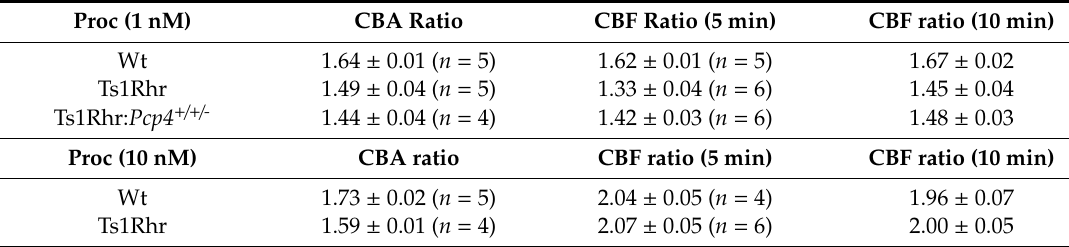
Figure 2. Increases in CBF and CBA ratios of airway cilia stimulated by 1 nM procaterol. Stimulation with procaterol (1 nM) increases CBF and CBA ratios of airway cilia in Wt, Ts1Rhr, and Ts1Rhr: Pcp4 +/+/ - . ( A ) Wt. The time course of the procaterol-stimulated CBF-increase is slower than that of the procaterol-stimulated CBA-increase. ( B ) Ts1Rhr. The time course of the procaterol-stimulated CBF increase is much slower in Ts1Rhr than in Wt. The plateau levels of the procaterol-stimulated CBF and CBA increases in Ts1Rhr are lower than those in Wt. ( C ) Ts1Rhr: Pcp4 +/+/ - . The time course of the procaterol stimulated CBF increase in Ts1Rhr: Pcp4 +/+/ - is similar to that in Wt, although the plateau levels of CBF and CBA during procaterol stimulation are lower in Ts1Rhr than in Wt. ( D ) The time courses of procaterol-stimulated CBF and CBA increases in Wt, Ts1Rhr, and Ts1Rhr: Pcp4 +/+/ - . The procaterol-stimulated increases in CBF and CBA (normalized values) were fitted to an exponential curve, a • [1-exp(-t / τ )]. The fitted curves show a slower time course of the procaterol-stimulated CBF increase in Ts1Rhr than that in Wt or Ts1Rhr: Pcp4 +/+/ - , although the time courses of the CBA increases are similar in Wt, Ts1Rhr, and Ts1Rhr: Pcp4 +/+/ - . Table 2. CBF ratio and CBA ratio 5 min and 10 min after procaterol (Proc)